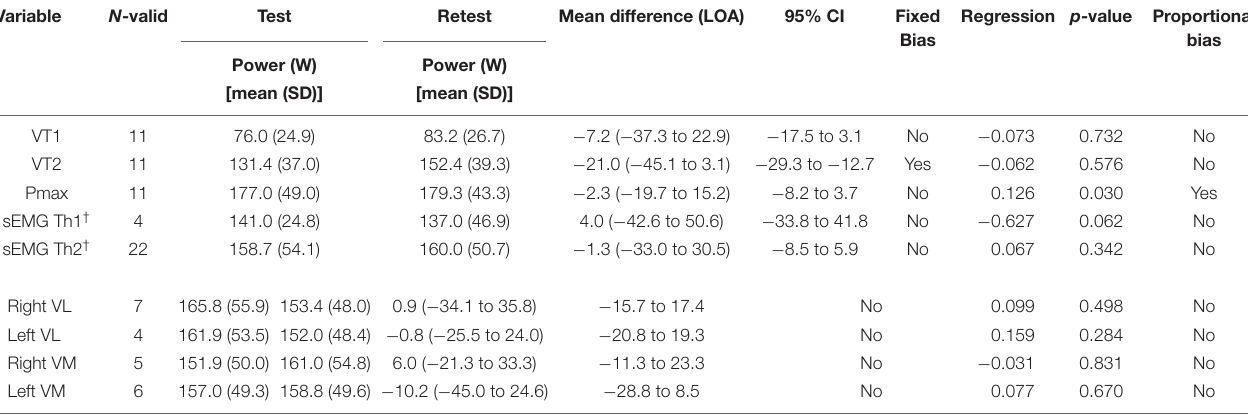
TABLE 4 | Test–retest reliability for maximal power ventilatory and EMG thresholds of the first test compared to the second test.